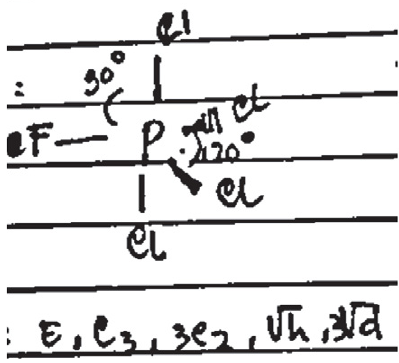
Figure 4. Example of an incorrect answer of SCM students regard- ing PFCl 4